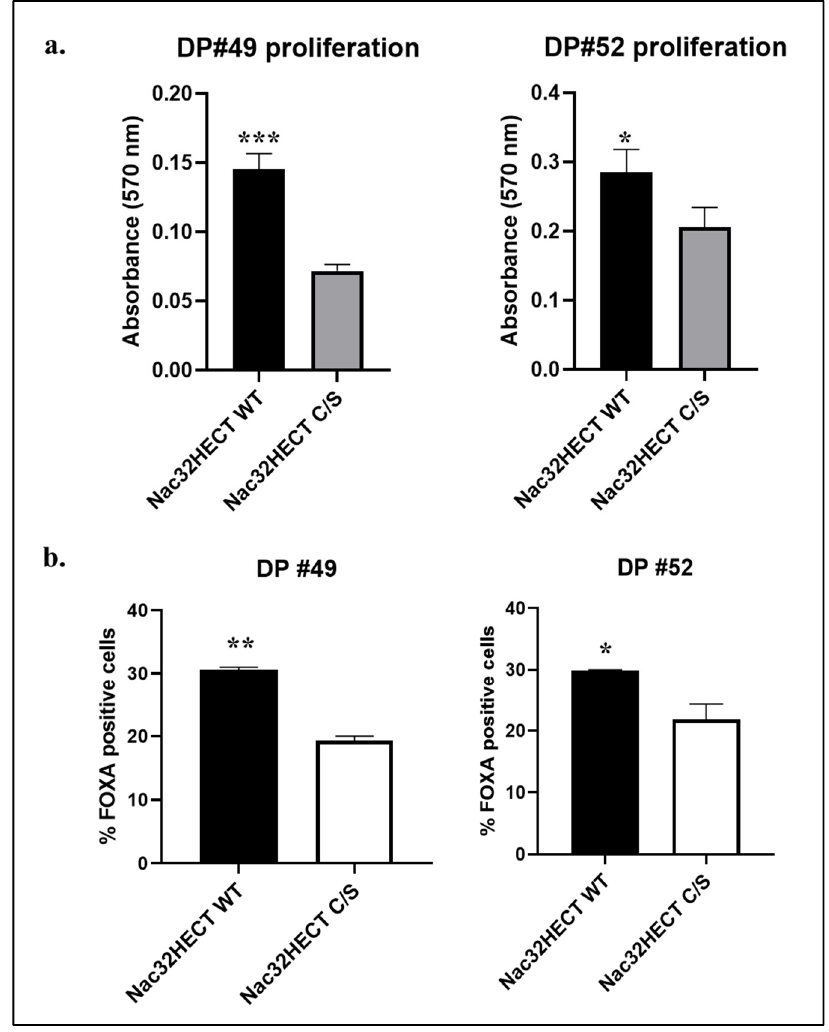
Figure 10. WT Nac32HECT ubiquibody rescues PD NCS differentiation into DPs. NSCs #49 and #52 were transduced with RLPs expressing similar amounts of WT and C/S Nac32HECT ubiquibodies and cells were differentiated into DPs. Next, ( a ) a proliferation assay was performed by adopting the commercial kit CyQUANT™ NF Cell Proliferation Assay (ThermoFisher Scientific), along with ( b ) an evaluation of FOXA2 positive cells by FACS analysis. Statistical differences were determined by p -values of * p < 0.0332; ** p < 0.002; *** p < 0.0002 . Overall, these data suggest that WT Nac32HECT, by interfering with aS intracellular amounts, partially rescues PD patient-derived NSC’s ability to differentiate in DPs.